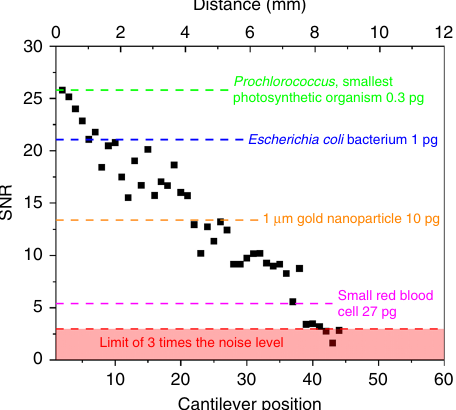
Fig. 6 Minimum detectable mass for weak-coupling peaks. Signal-to-noise ratio (SNR) of the weak-coupling peaks of a 44 resonators array as a function of the position from the cantilever under measurement. The physical distance is also reported on the top axis. The limit of detection for the weak-coupling peaks is reported with dashed lines corresponding to the mass of some typical (nominated) targets of interest in chemical